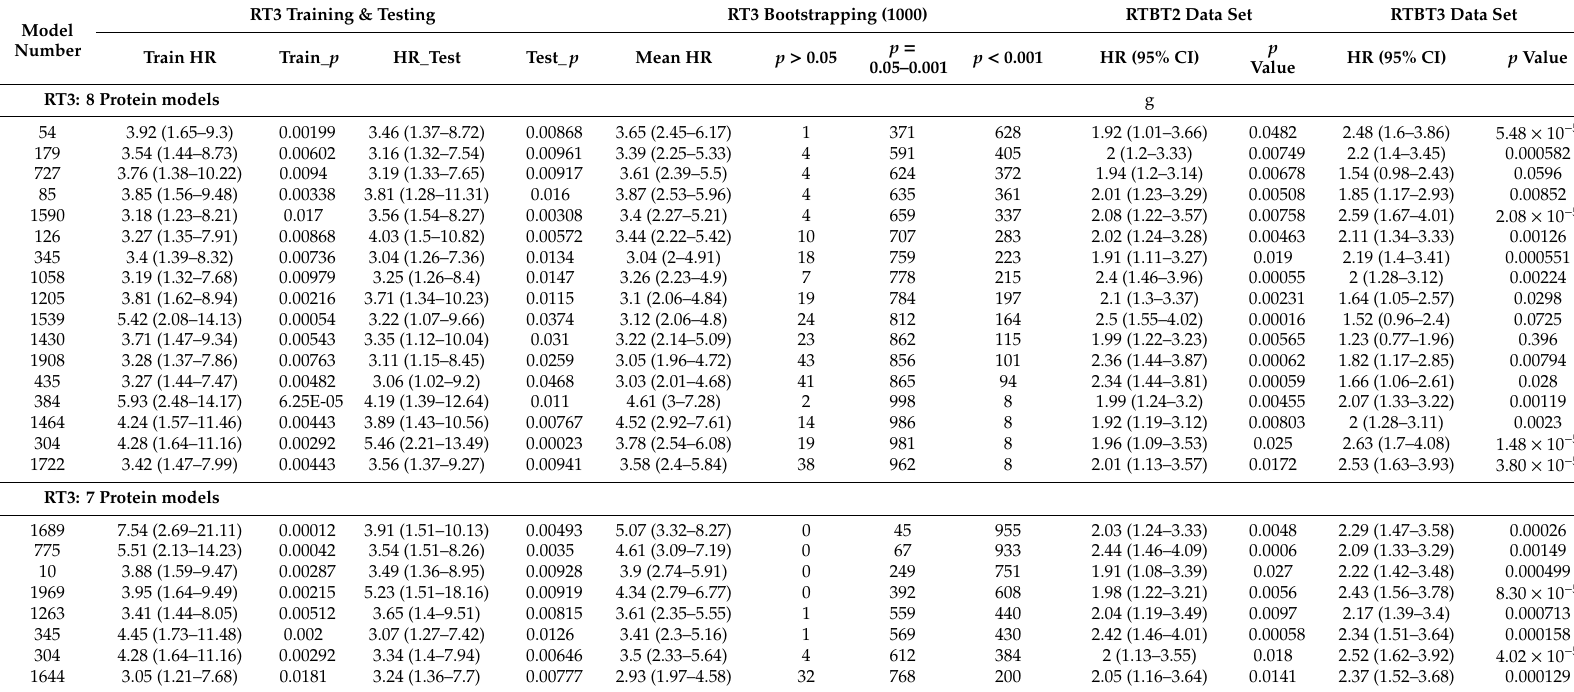
Number of models counted for p value intervals in the